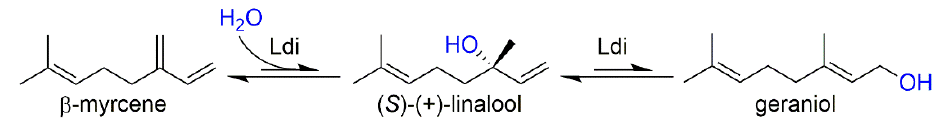
Figure 1. Overall structure and a close-up view of the active site of Ldi (PDB code: 5G1U [6]). Bound geraniol (purple) and the essential cysteines are highlighted in sticks. Cysteines 48 and 101 form a